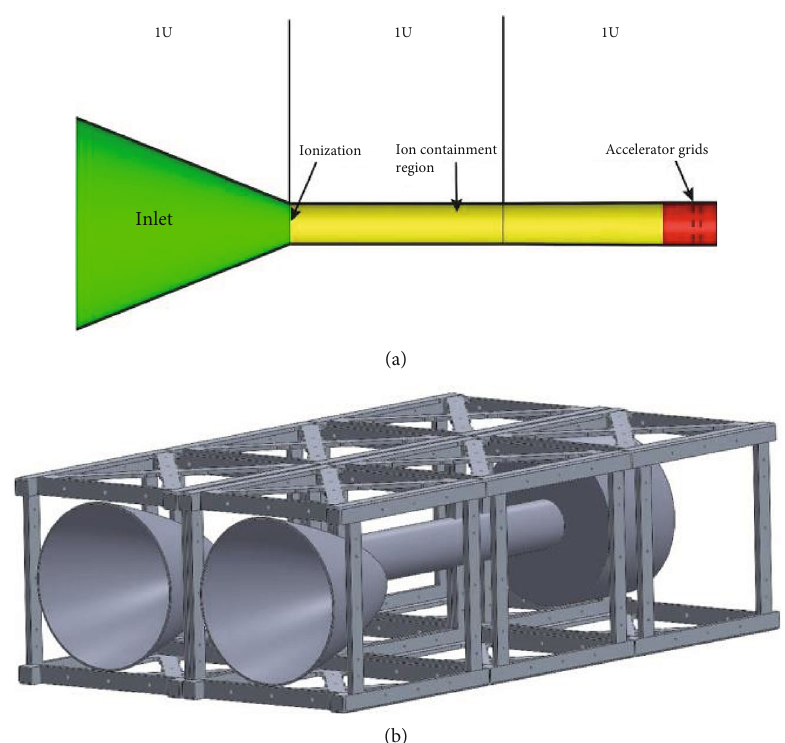
Figure 19: Jackson ’ s ABIT: (a) representations of the cross-section of the proposed system; (b) mockup of the 6U sized thruster system [40].